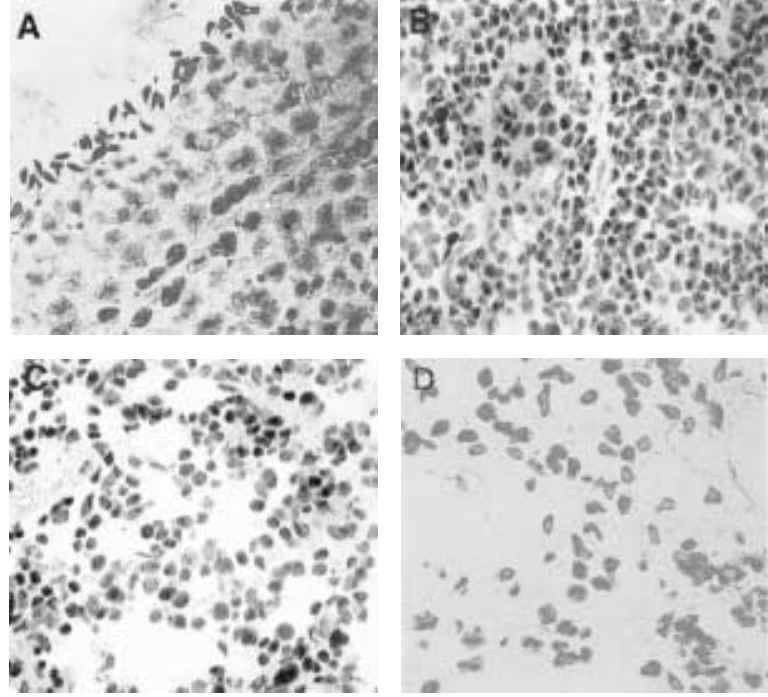
Fig. 5. Immunoperoxidase stained frozen section of mouse tissues. A,testis: the secondary spermatocytes are TK1 positive (brown, counterstained with hematoxylin); B, germinal center of the spleen; C, red pulp of the spleen; D,